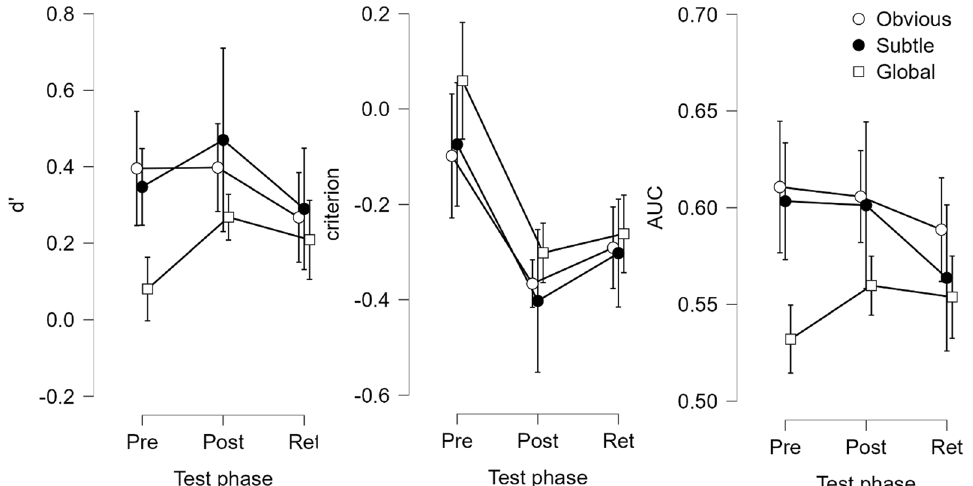
Fig. 3 Mean d’, criterion, and AUC across test phases ( image type (‘circle’ Obvious, ‘Bullet’ Subtle, ‘Square’